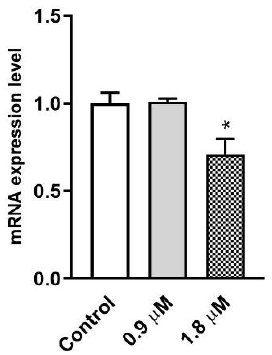
Figure 6. Real-time PCR analysis of ABCB1 mRNA levels in HL-60 cells treated with 5a for 24 h. Data are presented as mean ± SEM of three independent experiments. Statistical significance was assessed using one-way ANOVA and a post-hoc multiple comparison Student–Newman–Keuls test. * p < 0.05 vs. control.